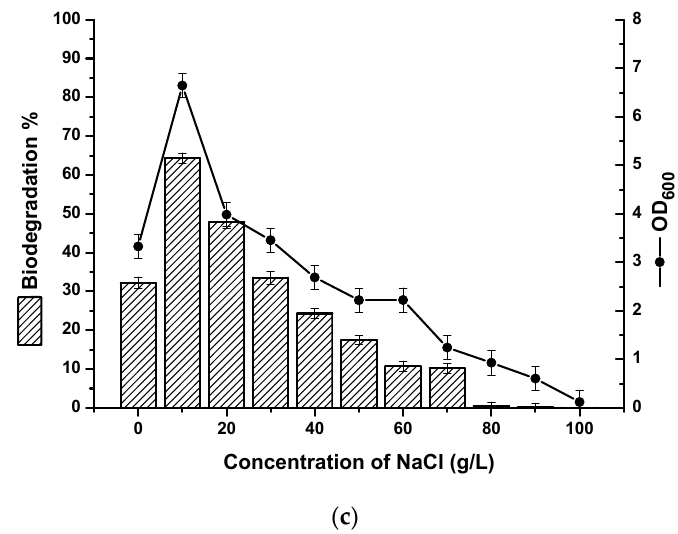
Figure 2. Effects of ( a ) temperature (5–65 °C) at a pH of 7.0 and salinity of 10 g/L; ( b ) pH (1.0–12.0), at a temperature of 45 °C, and salinity of 10 g/L; and ( c ) salinity (0–100 g/L) at a temperature of 45 °C and pH of 7.0 on the cell growth of B. subtilis strain BL-27 in LB medium and biodegradation of crude oil in MSM medium at 150 rpm by the strain BL-27 (6%, v/v ).